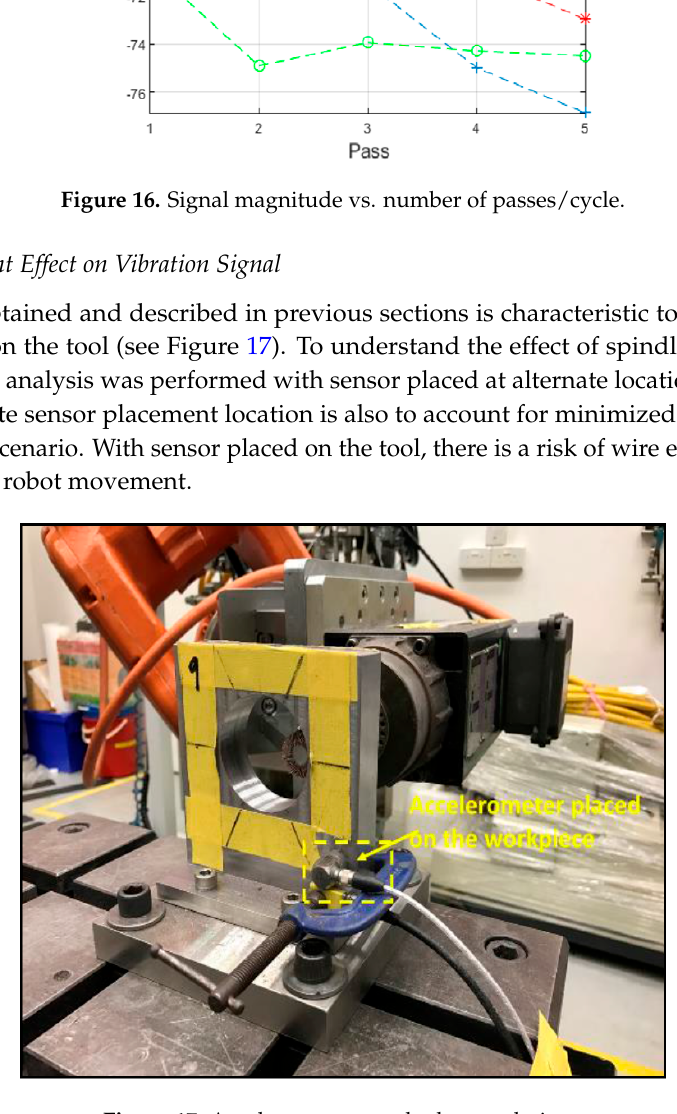
Figure 17. Accelerometer attached to workpiece.